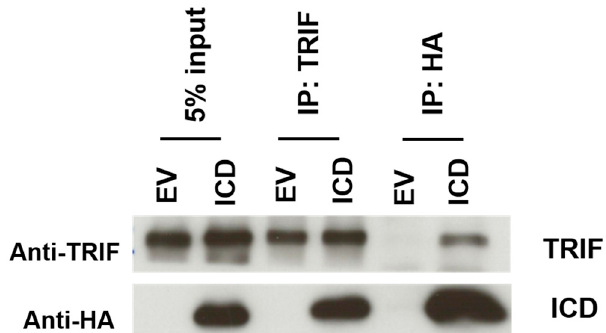
Figure 8. The ICD of I329L interacts with TRIF. HEK-293T cells were transfected with pcDNA3-HA (EV) or pcDNA3-ICD-HA (ICD) and pCMV-TRIF. After 48 h, cell lysates were subjected to immuno- precipitation using antibodies for TRIF or HA (to capture I329L ICD). The immunoprecipitates were then analyzed for the presence of I329L and TRIF by Western blot.